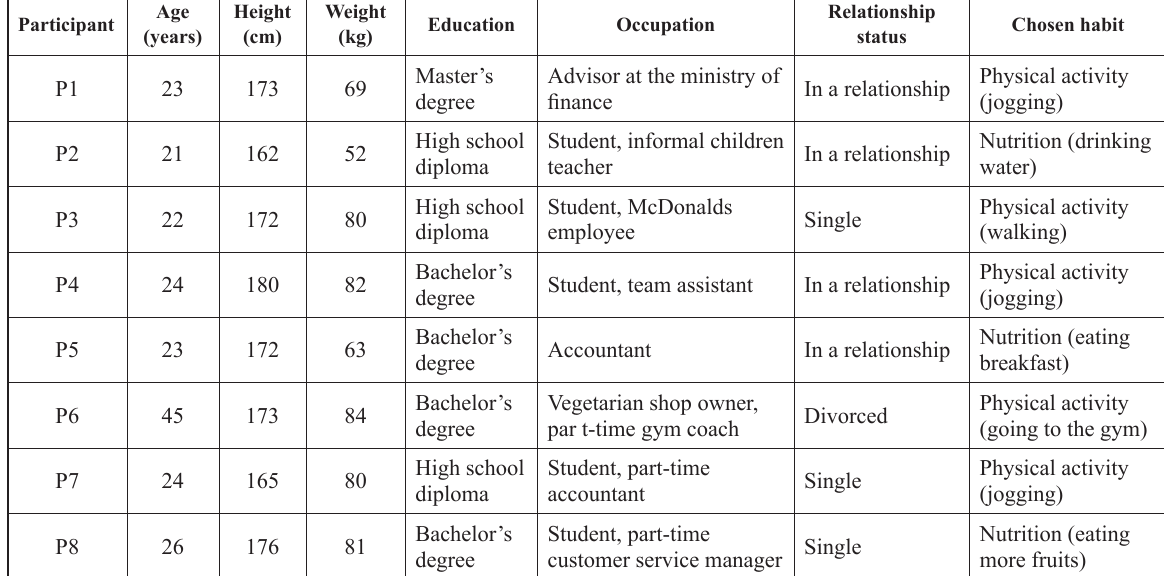
Table 1. Characteristics of